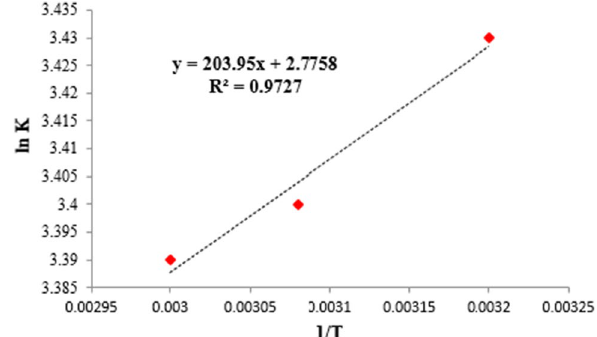
Fig. 15 Thermodynamic study of MG dye adsorption on NLP (NLP: 3 g/l, MG: 100 mg/l, pH: 4.58)